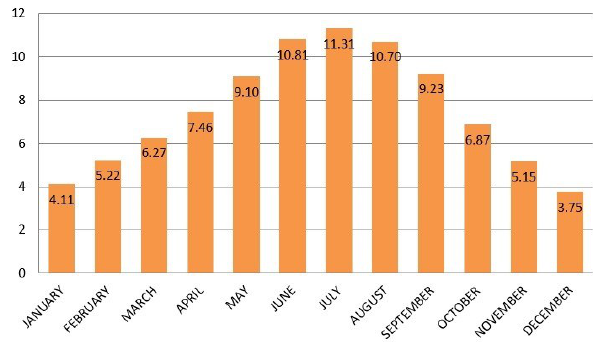
Figure 3. Sunshine Duration Per Month (General Directorate of Renewable Energy,